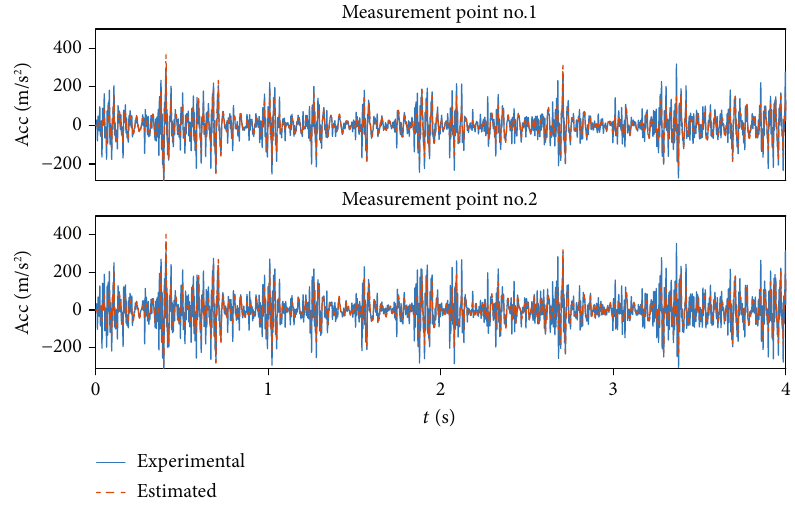
Figure 8: Comparison between the experimental and estimated acceleration signals. Table 1: Natural frequency estimates and mean square errors.